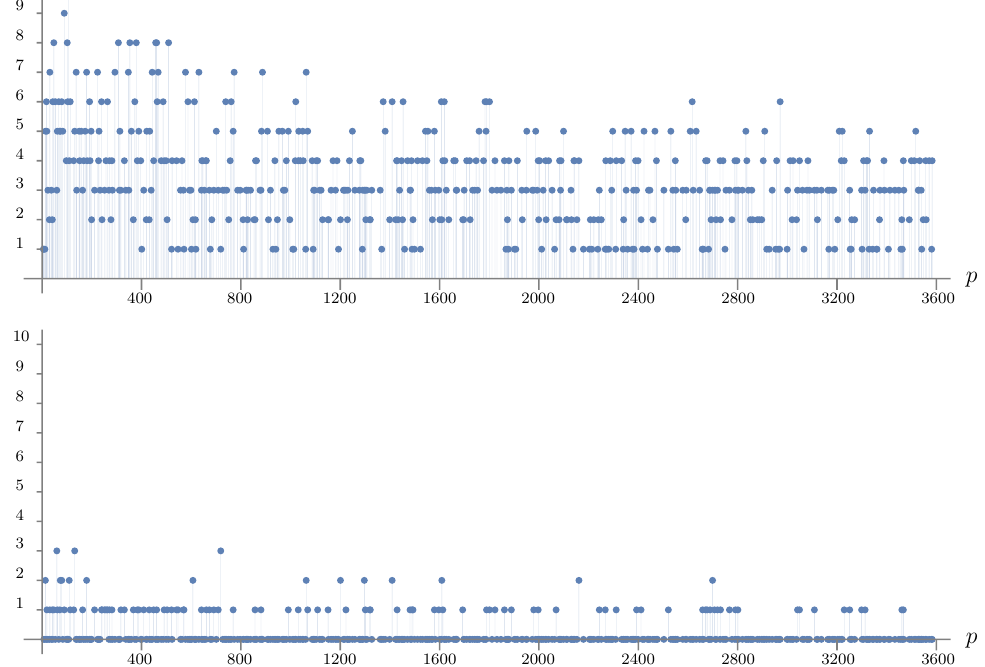
Figure 5 . The upper plot shows the number of factorisations into two quadrics as ’ varies over each F p , 7 (cid:20) p (cid:20) 3583, for the manifold AESZ34. For comparison, the lower plot provides the same information for the mirror of the quintic which explains why it is di(cid:14)cult to (cid:12)nd rank two attractor points on this